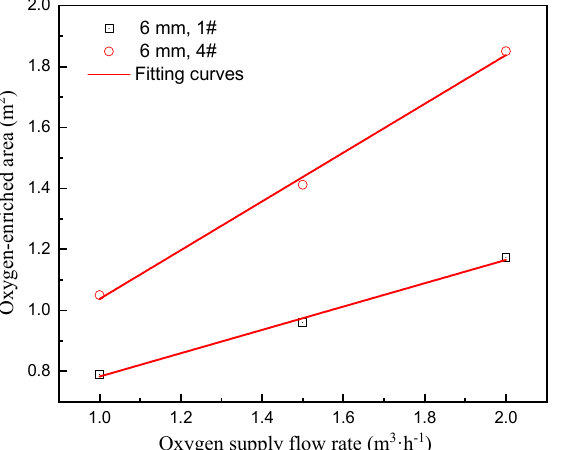
Figure 11. Oxygen-enriched area with different oxygen supply modes and oxygen flow rates un- der air-conditioning. Table 6. The relationship between oxygen-enriched area and oxygen flow rate under air-condi- tioning.